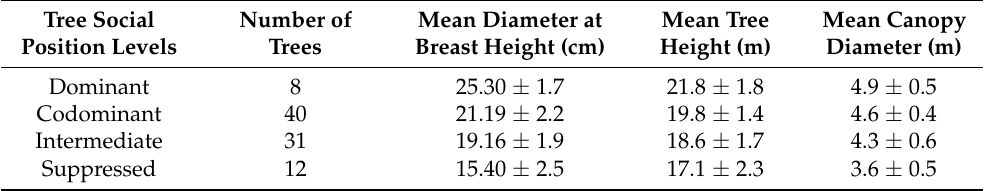
Table 3. The vertical structure characteristics of Larix principis - rupprechtii plantation plot in the down slope ( DS ) (means ± standard deviations).